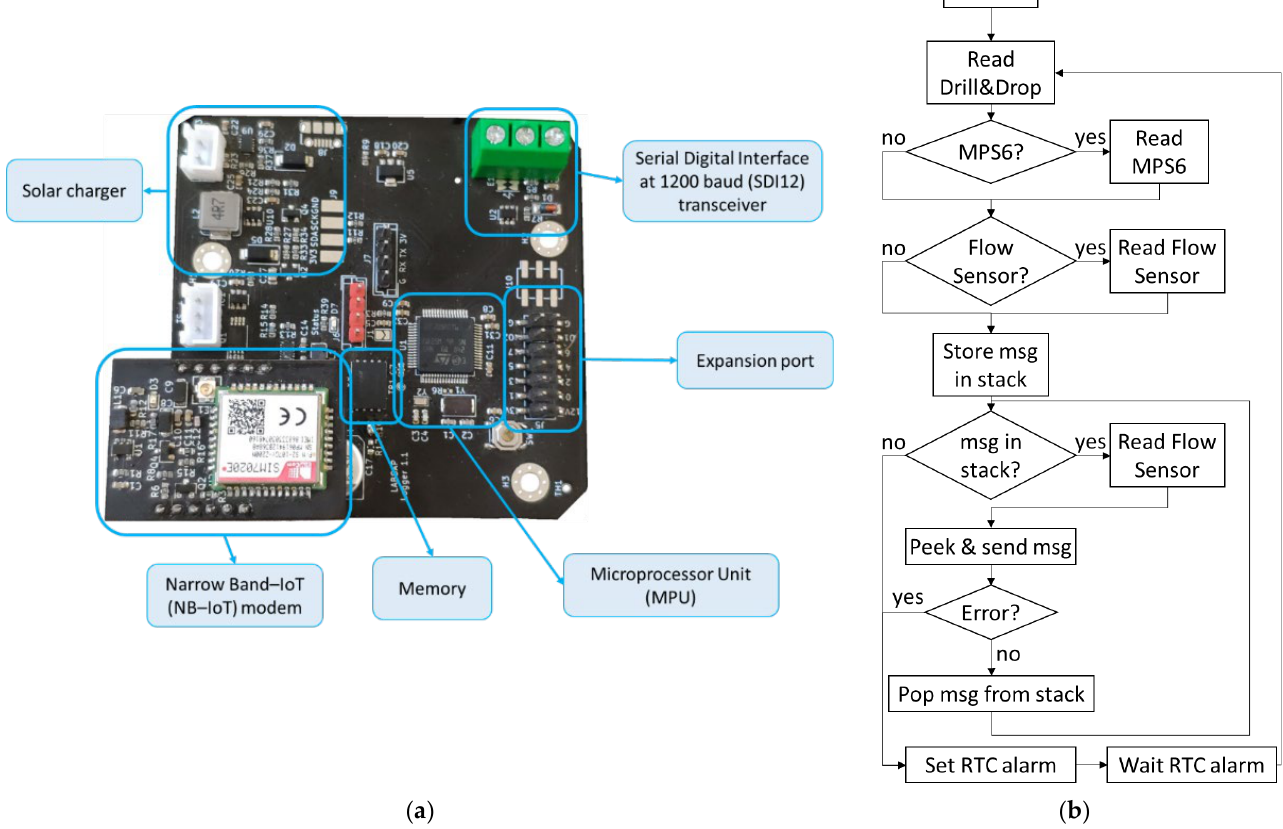
Figure 2. Data logger designed for crop level data acquisition: ( a ) Detail of the electronic design and main hardware components of the data logger. ( b ) Flowchart describing how the firmware runs for gathering, locally storing and sharing read sensed data with the Cloud.